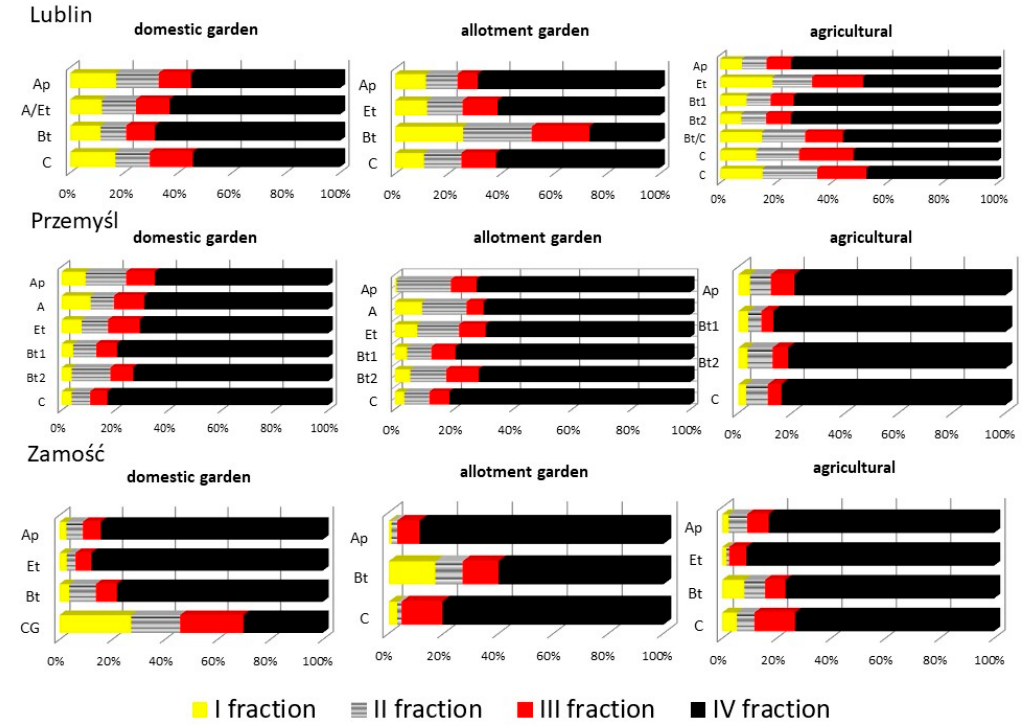
Figure 3. Percentage content of Zn fractions in silty soils.